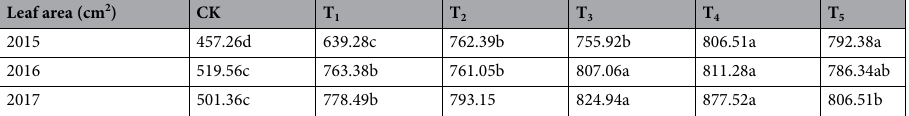
Table 1. Effect of biochar treatment on tobacco leaf area coefficient. Different lowercase letters indicate significant differences between treatments in the same year at the 0.05 level.